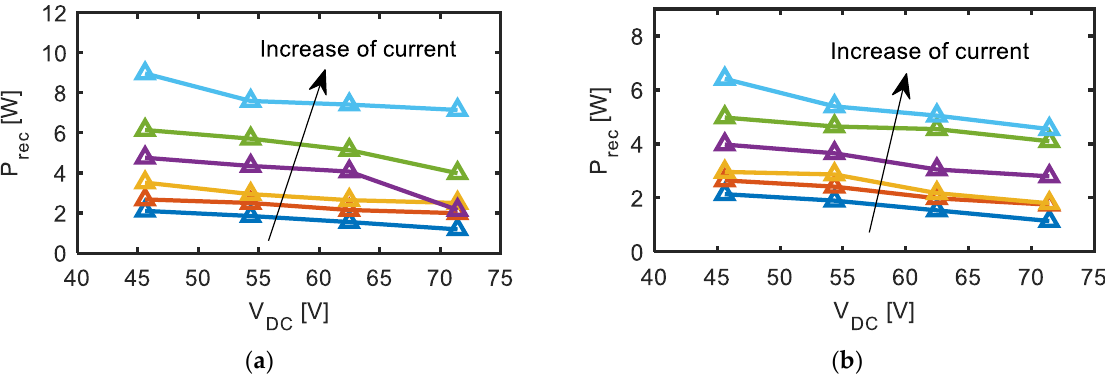
Figure 10. The rectifier losses at different DC-link voltages and different motor currents and current angles of ( a ) 50° and ( b ) 25°.